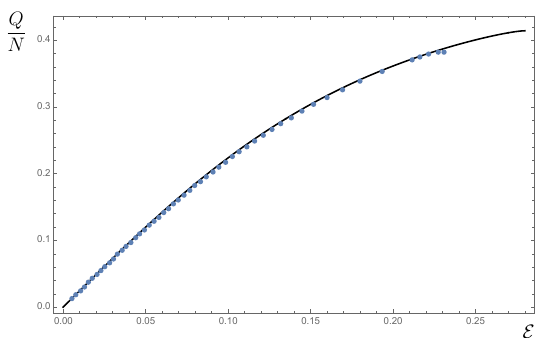
Figure 5 . Plot of Q ( E ) computed with the numerical solution of the Schwinger-Dyson equations for q = 3 (blue dots). Shown in solid black line is the analytic formula (2.50), analogous to the Luttinger-Ward